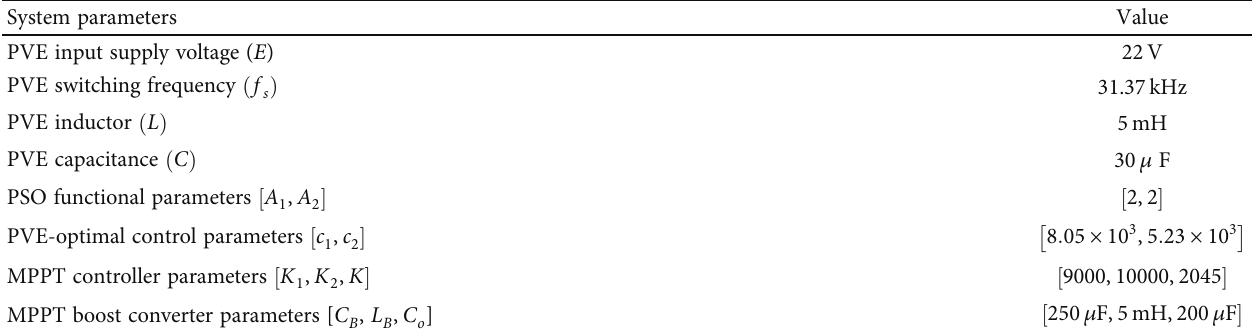
Table 1: Key parameters of the proposed PVE and the tested MPPT controller.